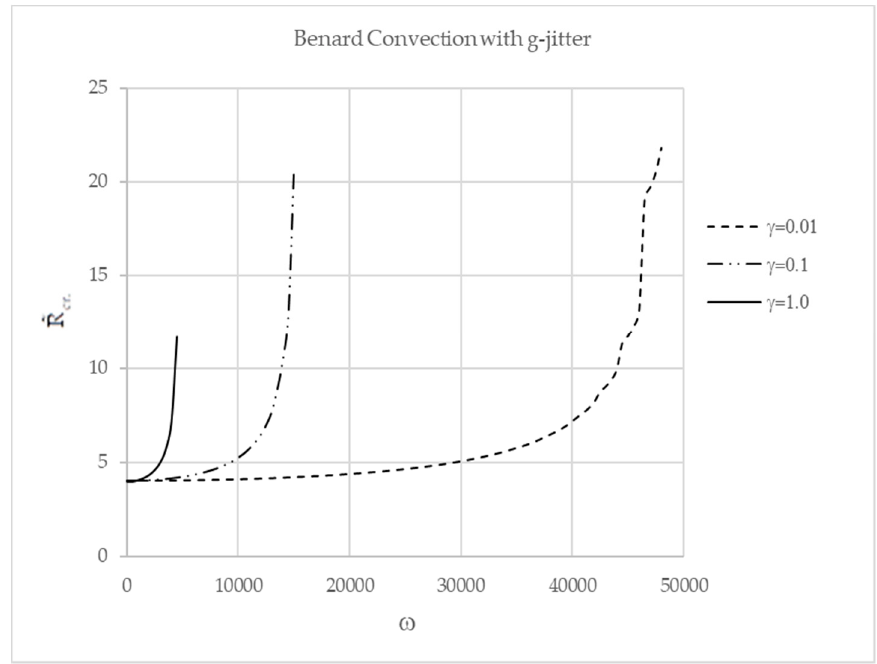
Figure 5. Benard Convection with g-jitter: Critical Rayleigh number versus vibration frequency at selected values of Vadasz number (no internal heat generation).